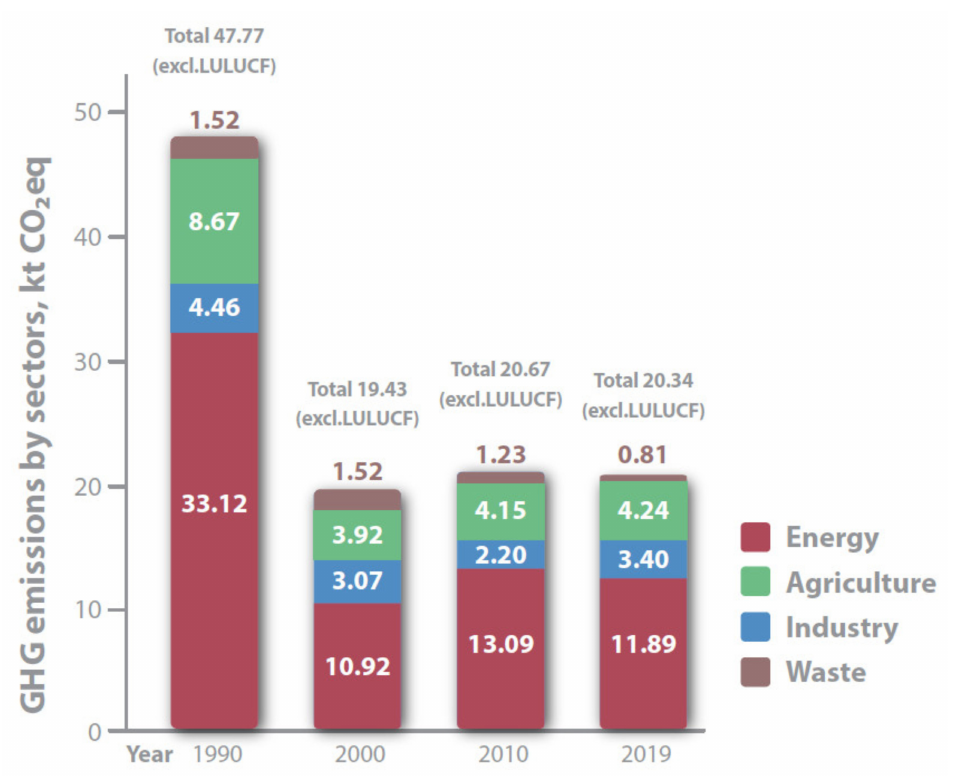
Figure 11. Lithuanian GHG emissions by sectors during the period from 1990 to 2019, kt CO 2